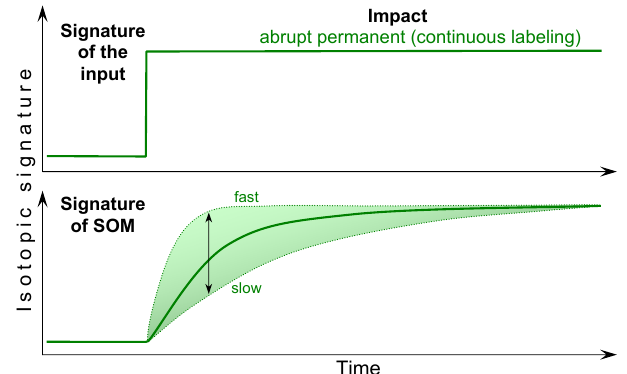
Fig. 3. Gradual permanent impact of isotopic signature of C input (above) and its effect on changes of isotopic signature of soil organic matter (below). The changes of isotopic signature are presented for bulk SOM (fat curve), as well as for pools with slow and fast turnover (dotted lines). The hight of arrows and the shaded area showing the differences in isotopic signature between the slow and fast pools is proportional to the sensetivity of the approach for each period. Explanations in text. Isotopic fractionations are not considered here, and theredore the SOM pools have identical isotopic compositions before the impact and at new steady state.